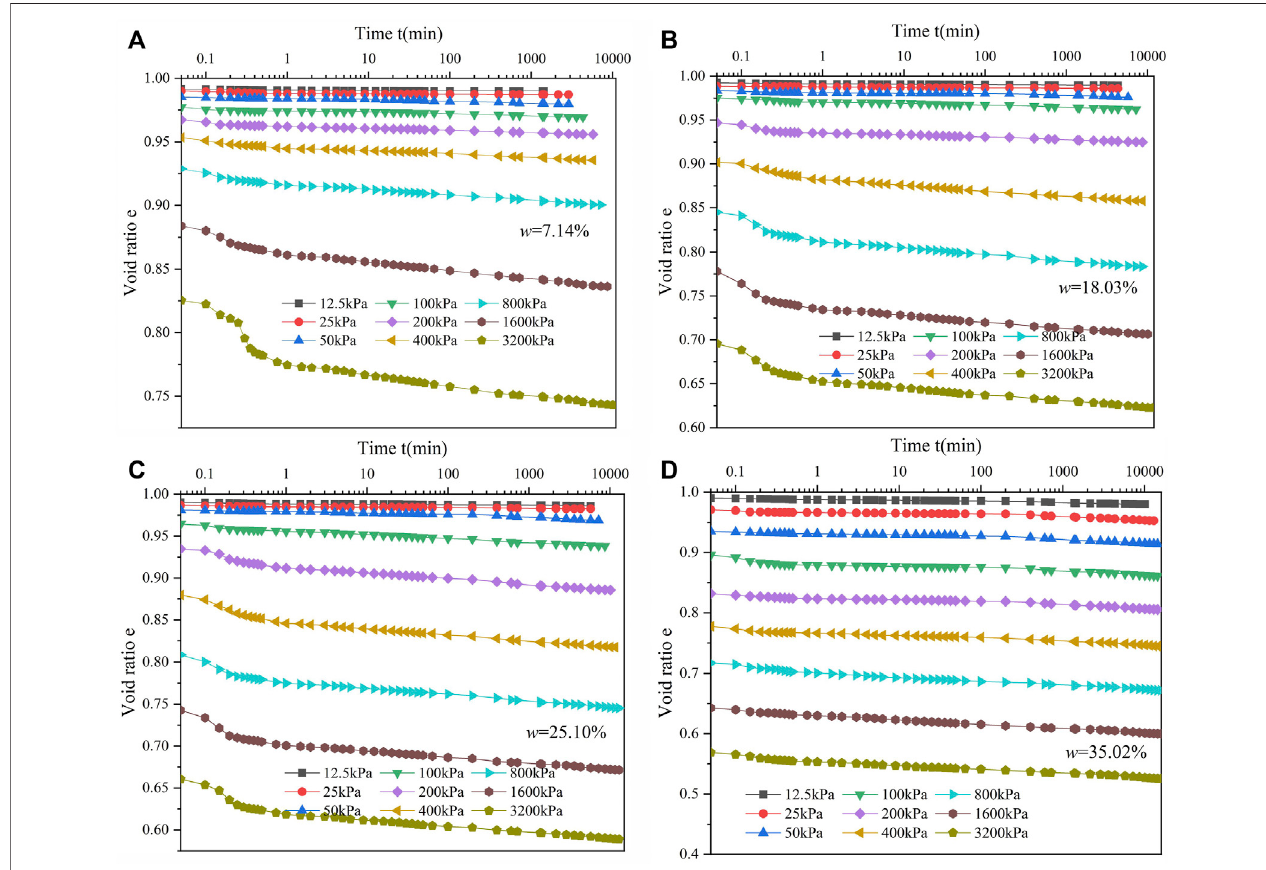
FIGURE 7 | Variation of the void ratio with time for intact loess: (A) w = 7.14%, (B) w = 18.03%, (C) w = 25.10%, and (D) w = 35.02%.